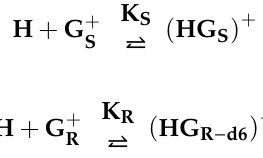
Figure 8. 1 H NMR spectra (CDCl 3 , 400 MHz, 298 K) of equimolar solution (3 mM) of ( R/S )- 4 and ( S )- 10 + ∙[B(Ar F ) 4 ] − at: ( a ) 298 K and ( b ) 243 K.